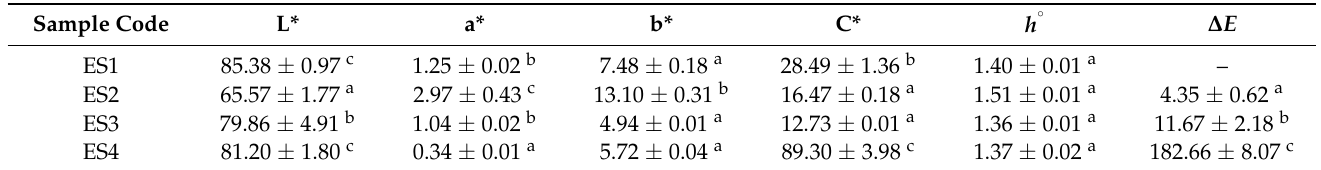
Table 4. The color parameters of the dressing-type emulsion stabilized with hydrocolloids from butternut squash seeds at pH